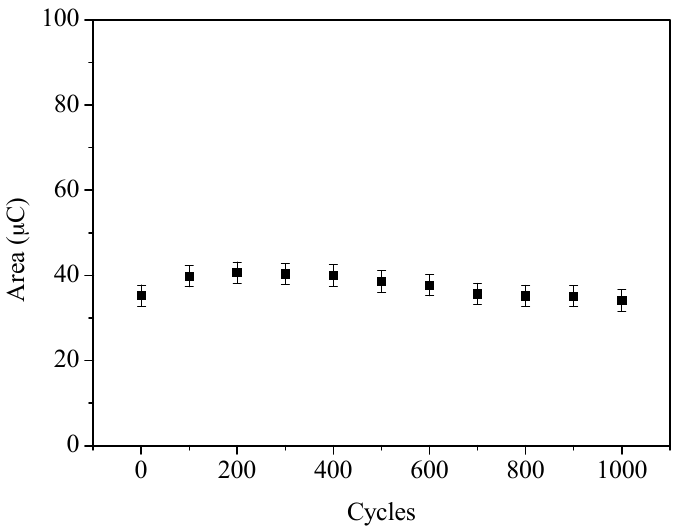
Figure 7. Study of electrode stability evaluating the glycerol oxidation peak every 100 cycles for 1000 cycles using a 1.40 mmol L − 1 glycerol solution.